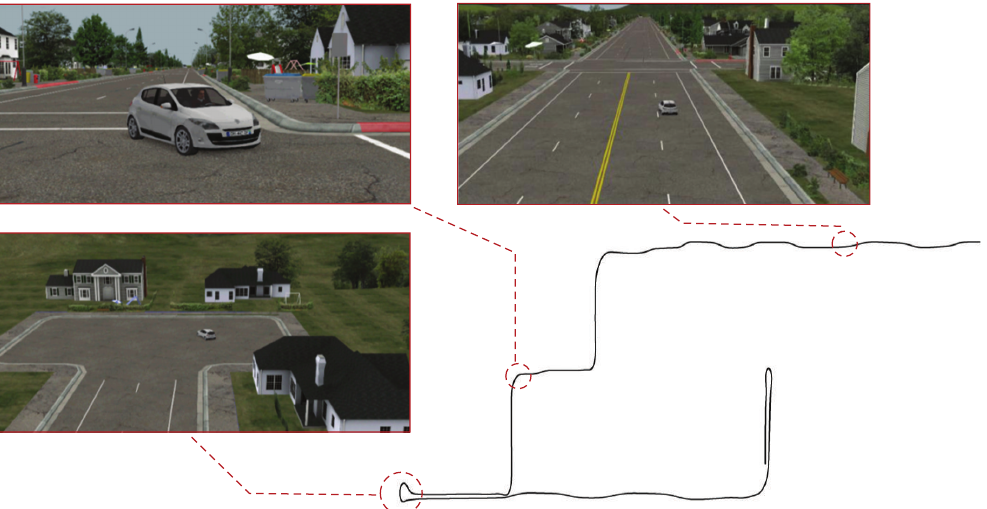
Figure 12: Actual trajectory and driving scenarios in driving